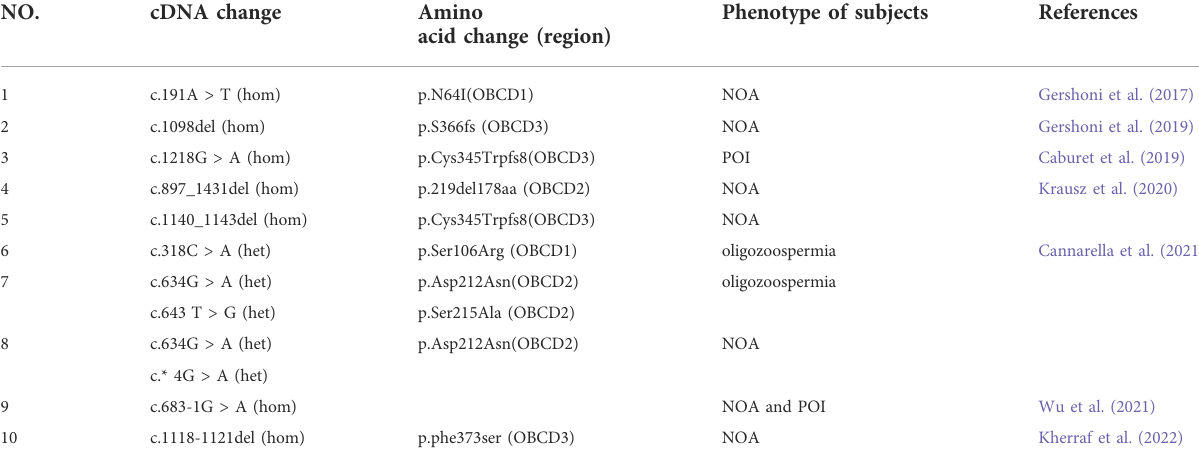
TABLE 1 The currently reported phenotypes and genotypes of MEIOB gene in infertility patients. NO. cDNA